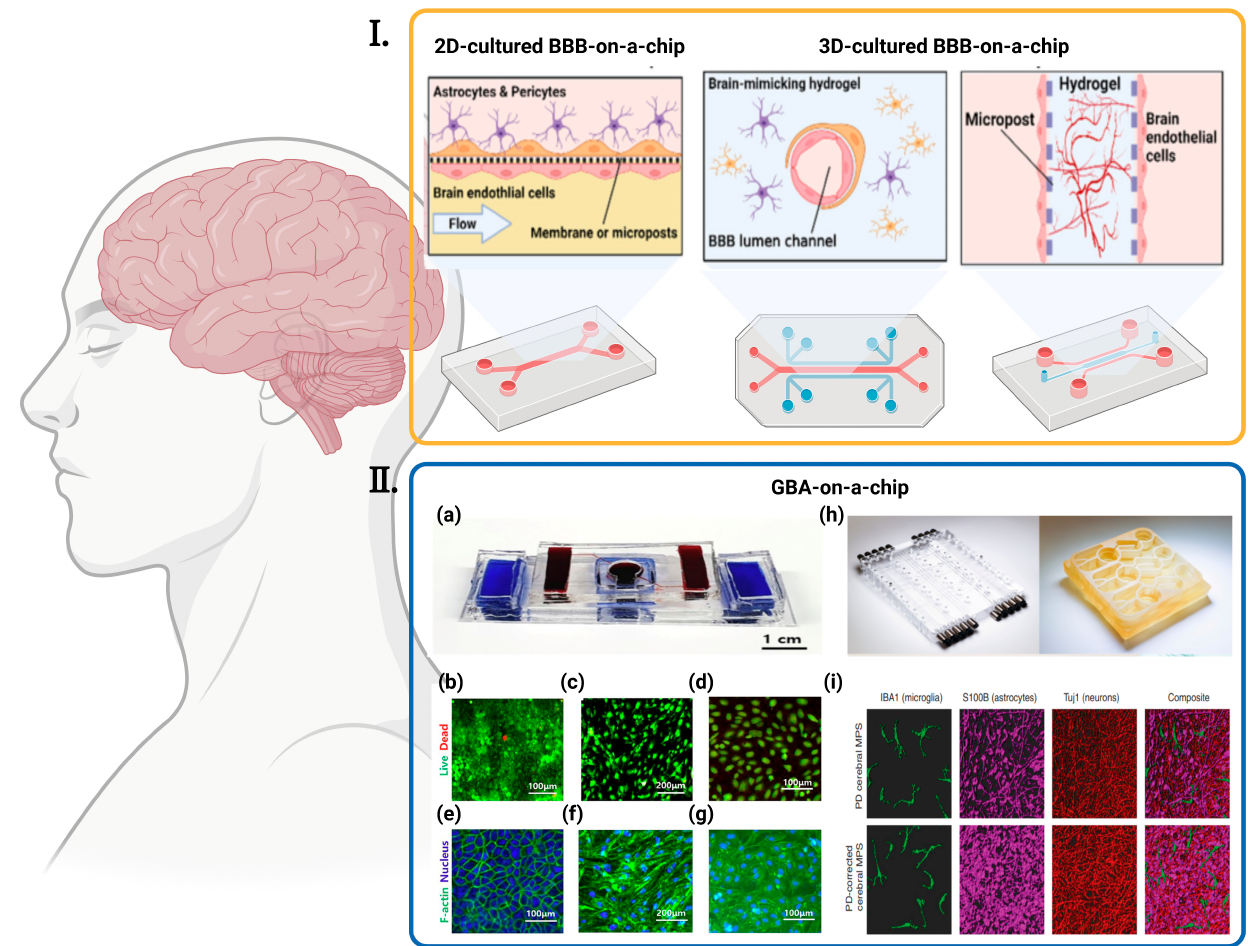
Figure 5. Various BBBs-on-a-chip and GBA-on-chip. ( I ) Strategies for reconstructing the in vitro BBB in an OOC platform are diverse. Cells can be cultured in a 2D environment under fluidic flow or 3D-cultured with different approaches, such as seeding in hollow hydrogel or the angio/vasculogenesis approach [27] ©Copyright 2020, MDPI. ( II ) Various GBA-on-chip. ( a ) The picture of assembled GBA chip [30] ©Copyright 2020, Elsevier; ( b – g ) Fluorescent images of cells seeded in the chip [30] ©Copyright 2020, Elsevier: ( b ) Live/Dead Images of Caco-2, ( c ) bEnd.3, and ( d ) hBMECs when co-cultured (green = live, red = dead). F-actin/nucleus stain images of ( e ) Caco-2 cells, ( f ) bEnd.3 cells and ( g ) hBMECs when co-cultured (blue = nucleus, green = F-actin); ( h ) Left: pneumatic plates machined in acrylic; Right: mesofluidic plate machined from monolithic polysulfone [82] ©Copyright 2021, Amer Assoc Advancement Science; ( i ) Representative, 3D rendered confocal images of the PD (top) and control PD-C (bottom) cerebral MPSs composed of hiPSC-derived microglia (green), astrocytes (purple), and neurons (red) cocultured on 0.4- μ m microporous 24-well Transwells [82] ©Copyright 2021, Amer Assoc Advancement Science.